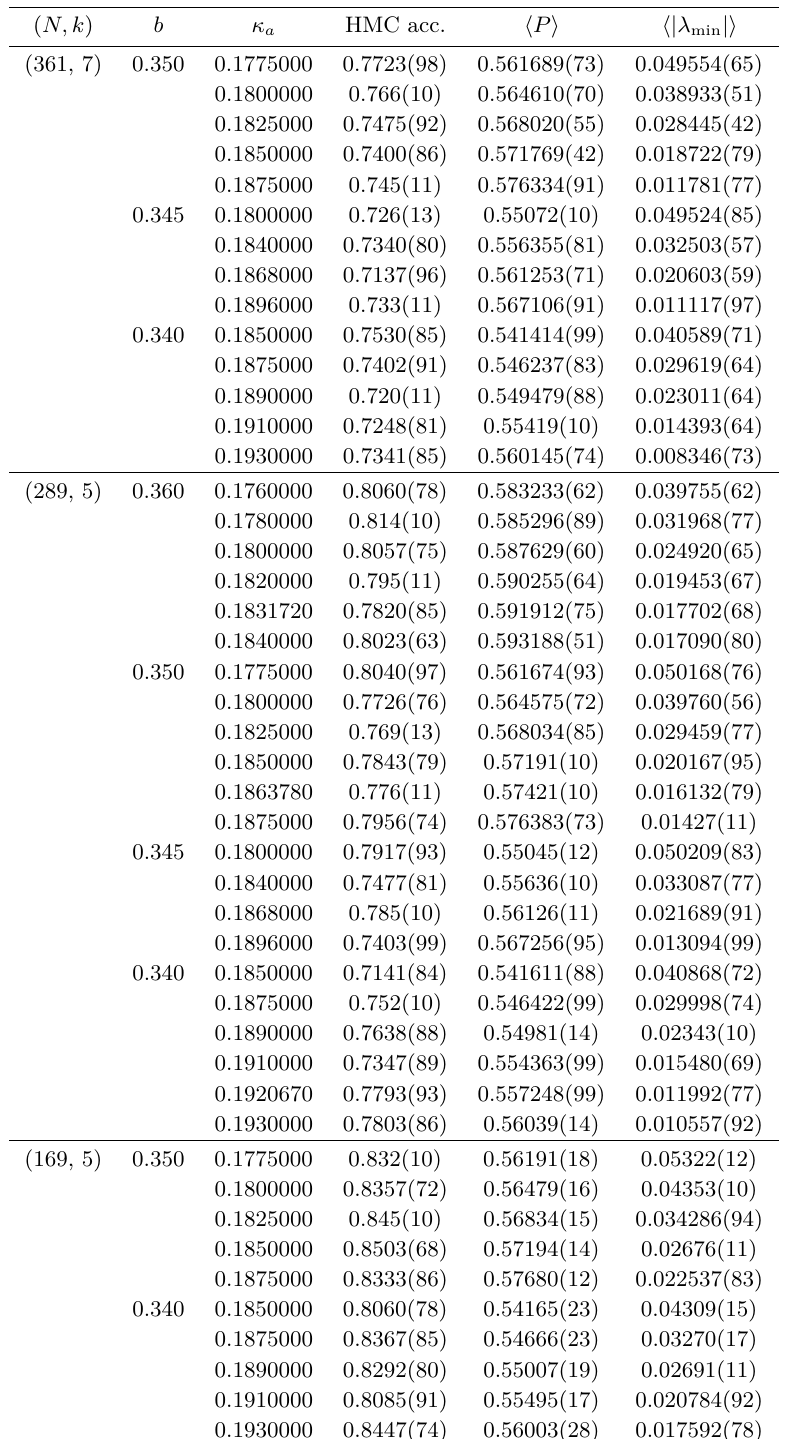
Table 8. For each value of N , b and κ the plaquette